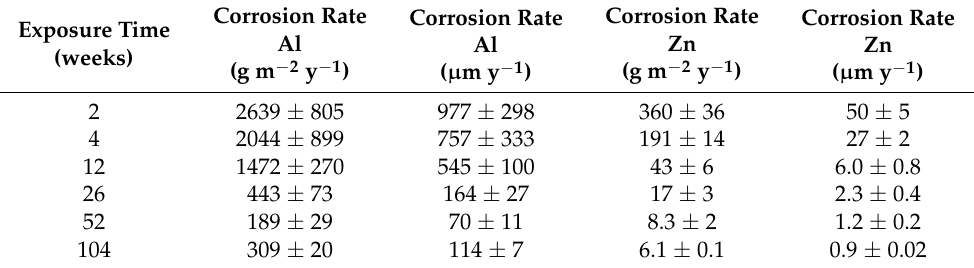
Table 2. Corrosion rates of Al and Zn embedded in concrete immersed in AGW at anaerobic conditions for 2, 4, 12, 24, 52 and 104